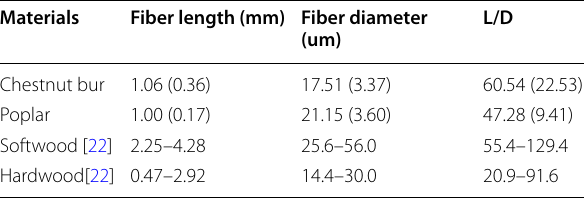
The results are given as averages and standard deviations (in parentheses) from the mean values of 100 randomly chosen fiber samples. L/D, length/diameter ratio of each fiber sample